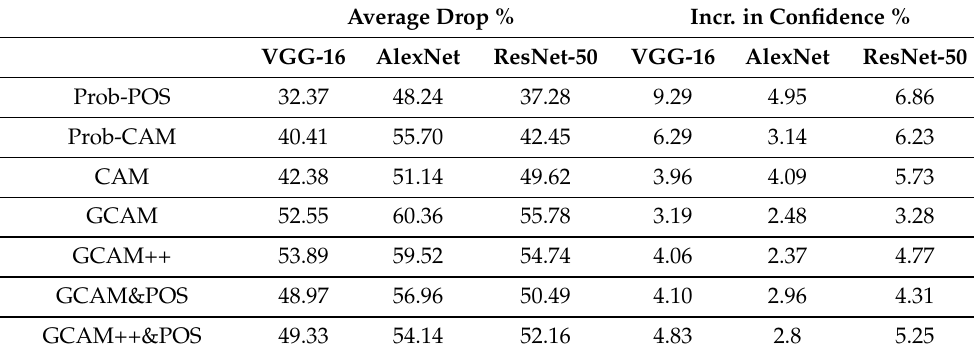
Table 7. Quantitative evaluation of faithfulness on UCM.